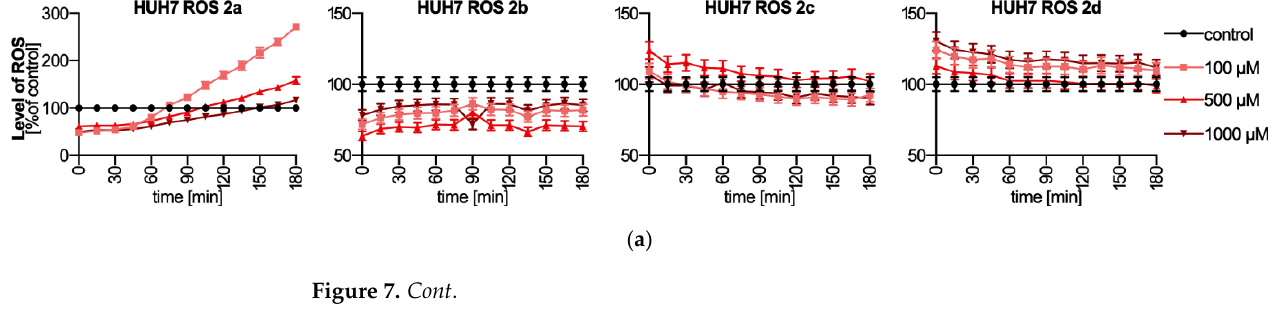
Figure 6. Comparison of changes in ( a ) ROS and ( b ) RNS levels in HepG2 cells treated with three different concentrations (100, 500 and 1000 μ M) of 2a – 2d for 0–180 min compared to ROS and RNS levels in a control sample (100%). ROS and RNS formation were tested overtime, in the range of 0– 180 min after the adding of the tested compounds. Results are presented as mean ± SD from three independent experiments. The significance of differences was estimated based on multifactor ANOVA and post-hoc Tukey tests. Statistical analysis for ROS level: HepG2+2a: p < 0.01: control vs. 120 min (100, 500 and 1000 μ M); p < 0.001 control vs. 0–105 min and 165–180 min (100, 500 and 1000 μ M); HepG2+2b: p < 0.001: control vs. 0–180 min (100, 500 and 1000 μ M); HepG2+2d: p < 0.001: control vs. 0–180 min (100 and 1000 μ M). Statistical analysis for RNS level: HepG2+2a: p < 0.05: control vs. 0 min (500 μ M); HepG2+2c: p < 0.05: control vs. 0–180 min (500 μ M). For more experimental details please see “Materials and Methods”.